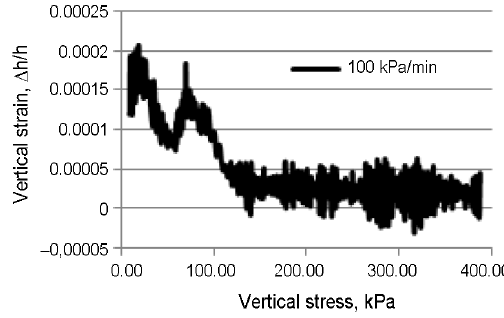
Fig. 11. Vertical stress versus vertical strain (100.0 kPa/min)